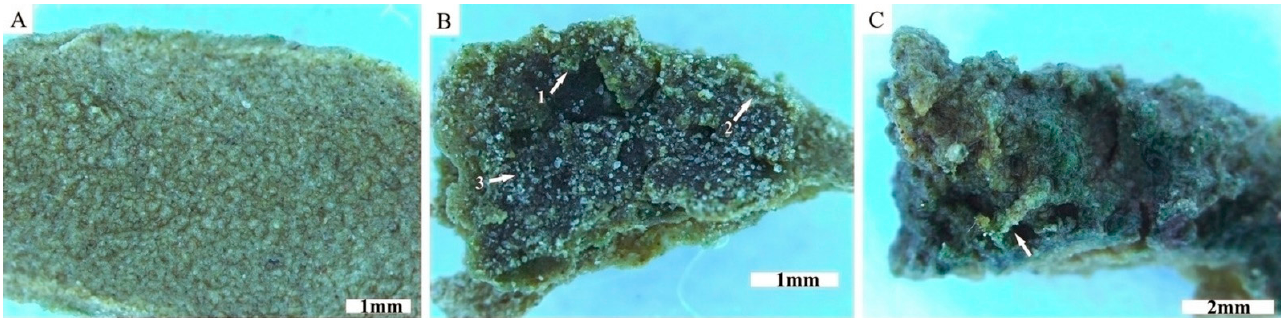
Figure 4. Morphology of formed biocrusts. Morphologically different colonies covered the surface of the experimental chamber: smooth biocrusts ( A ); biocrusts consisting of pinnacled ( B , arrow 1), curled ( B , arrow 2) and smooth structures ( B , arrow 3); pinnacled biocrusts ( C , arrow).